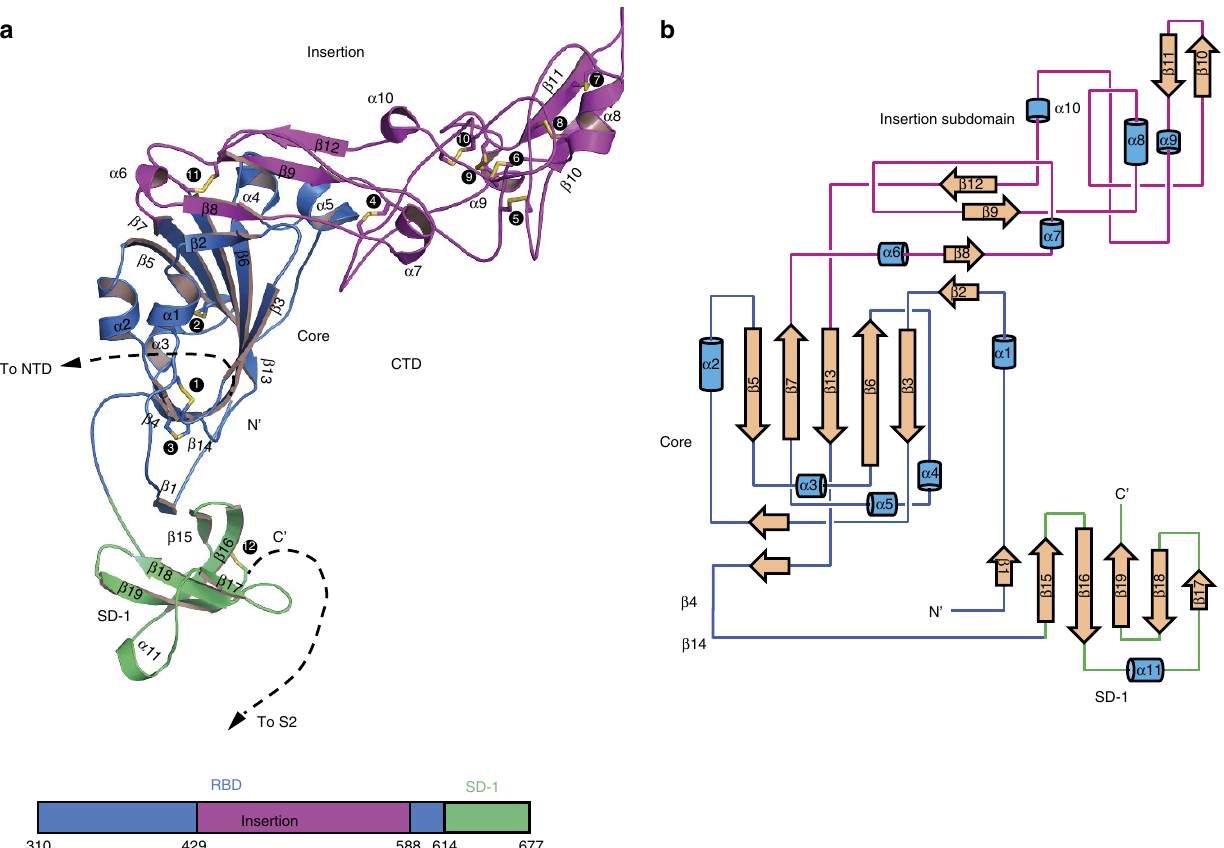
Figure 2 | Crystal structure of 1A-310-677aa. ( a , top) Ribbon model of 1A-310-677aa; bottom: schematic diagram of 1A-310-677aa. The core subdomain is shown in blue, the insertion loop is shown in magenta, and SD-1 subdomain is shown in green. Twelve pairs of disulfite bridges are numbered and shown in yellow and stick model. The amino acid numbers are from the S protein of the genotype A HKU1 virus. ( b ) Schematic illustration of the topological graph of 1A- 310-677aa. b -strands are shown with brown arrows, a -helices are shown with bright blue